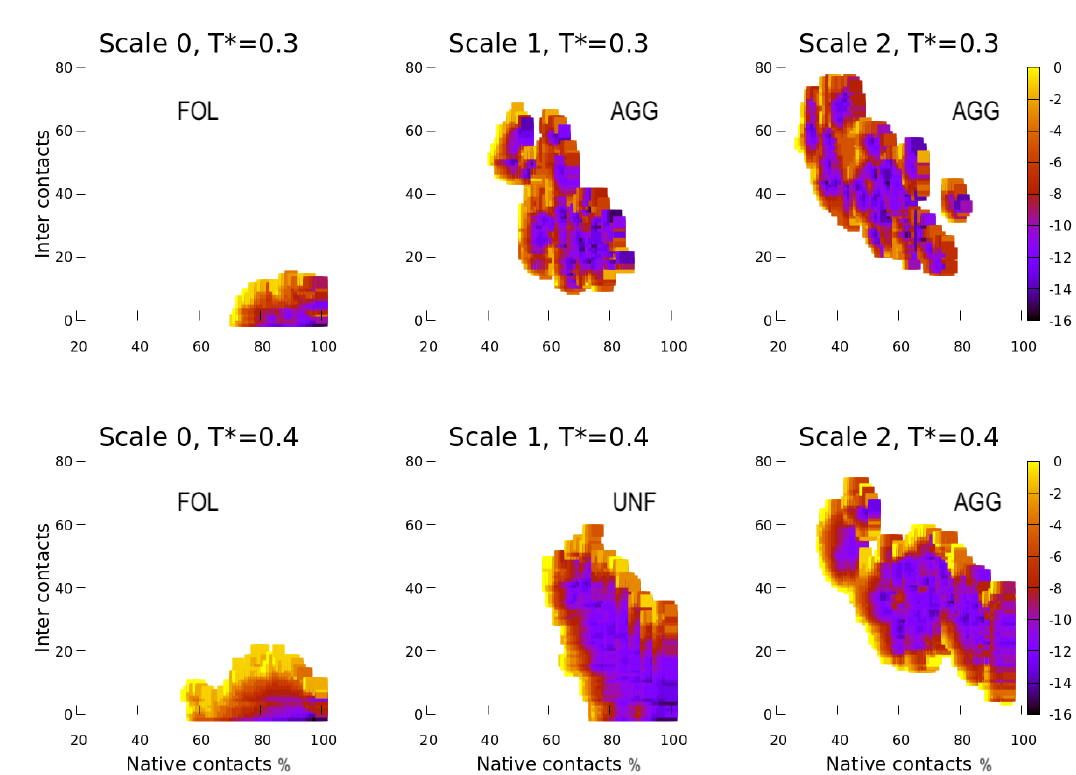
Figure 4. Comparing the free energy F ∗ ( N c , I c ) for different choices of model parameters, Scale 0, 1, 2 as indicated in Table 1, at fixed concentration c = 11%, and ambient temperature (top row) or warmer temperature (bottom row). Axes and colors are as in Figure 3. Under these conditions, F ∗ ( N c , I c ) for Scale 0 (left) has a minimum corresponding to folded proteins (FOL). For Scale 1 (center), at ambient temperature (top), the proteins are unfolded and aggregated (AGG), while at the higher temperature (bottom), they unfold (UNF) but have a small tendency to aggregate. For Scale 2 (right), at both temperatures, the proteins aggregate (AGG) and are more unfolded at the lower